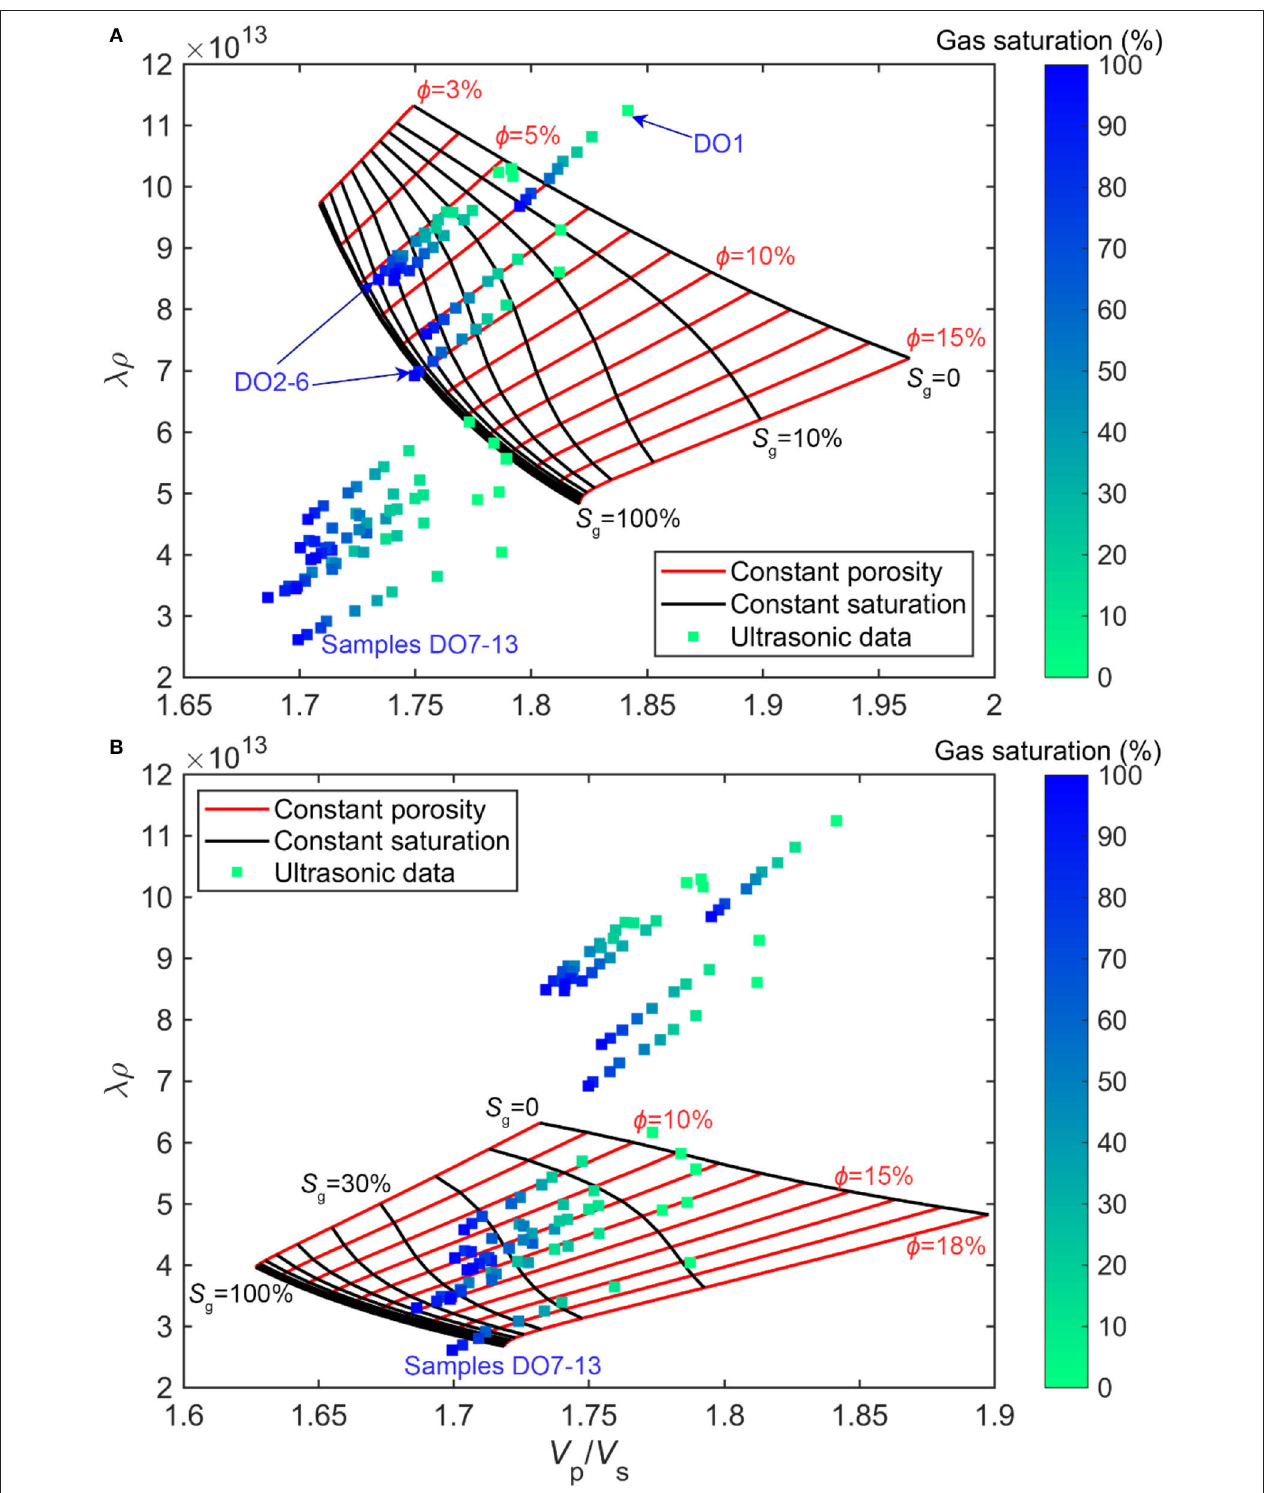
FIGURE 9 | Comparisons between the ultrasonic template and measured data for dolomites. (A) Template for samples DO1–6 with low porosities (4.99–6.93%). (B) Template for samples DO7–13 with relatively high porosities (10.37–16.87%).